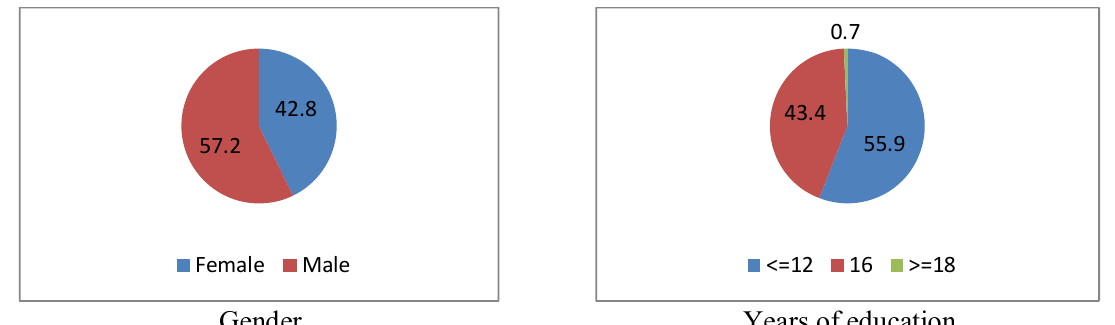
Fig. 1. Personal characteristics of the